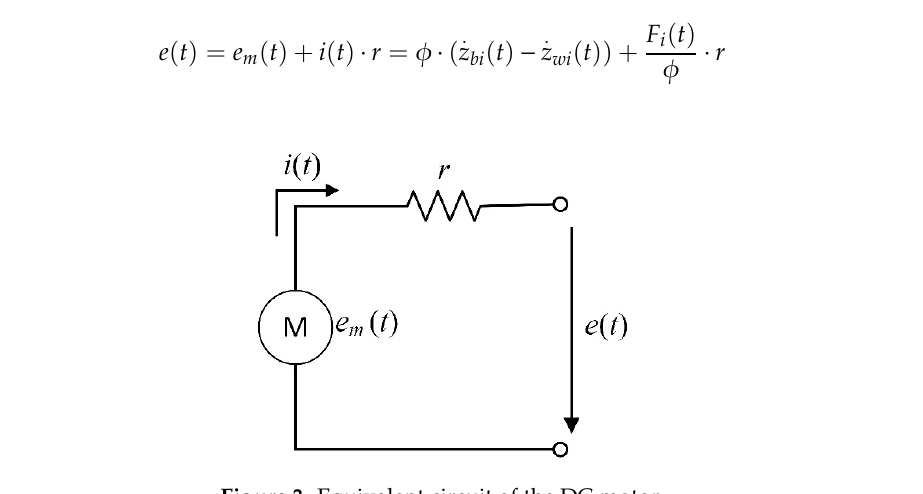
Figure 3. Equivalent circuit of the DC motor.